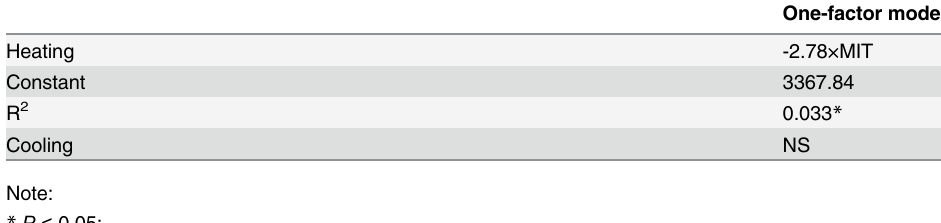
Table 4. Regression analysis for daily extreme energy consumption of large venue building against the climatic parameters.